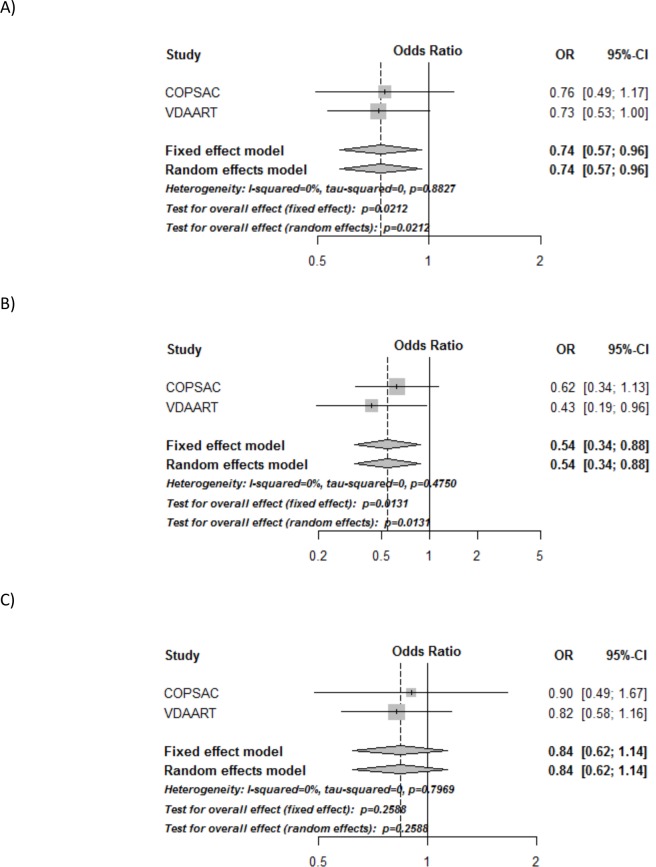
Forest plots of the combined analyses of asthma/recurrent wheeze in COPSAC2010 and VDAART.A) Combined analysis of the effect of randomization group, B) Combined analysis of women with initial 25(OH)D level ≥ 30 ng/ml, C) Combined analysis of women with initial 25(OH)D level < 30 ng/ml. All analyses are adjusted for gender, birth season and fish-oil intervention in COPSAC2010, and center and maternal education level in VDAART. All analyses of the average 25(OH)D level are also adjusted for intervention group. p<0.05 is shown in italic.